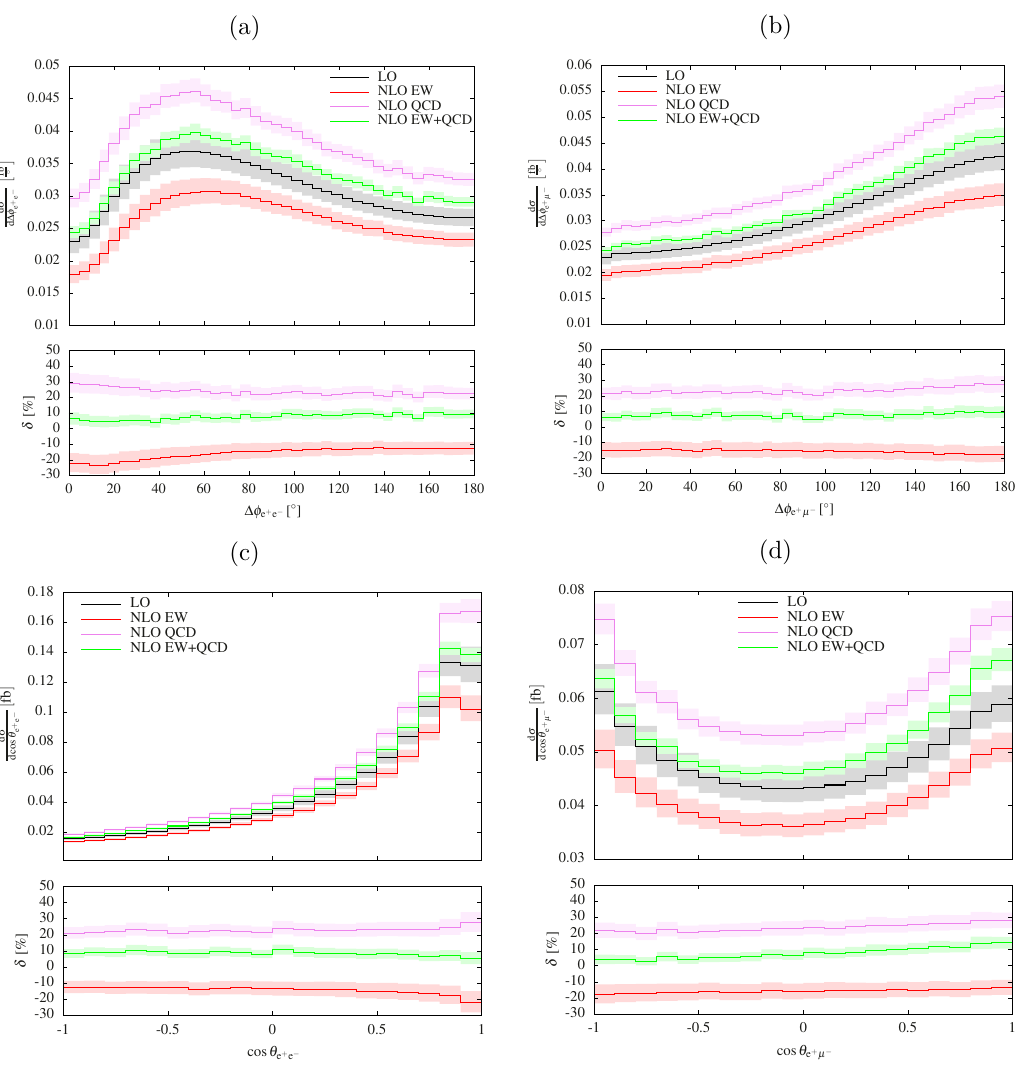
(cid:0) (cid:1) (cid:0) (cid:1) α 6 (LO), O α 7 (NLO EW),